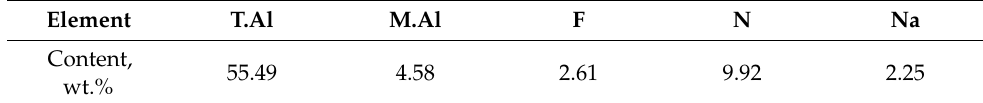
Table 2. Quantitative analysis of the secondary aluminum dross composition.